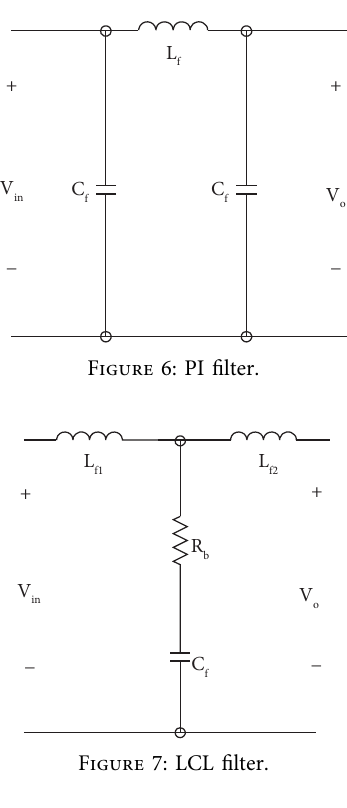
Figure 6: PI flter.